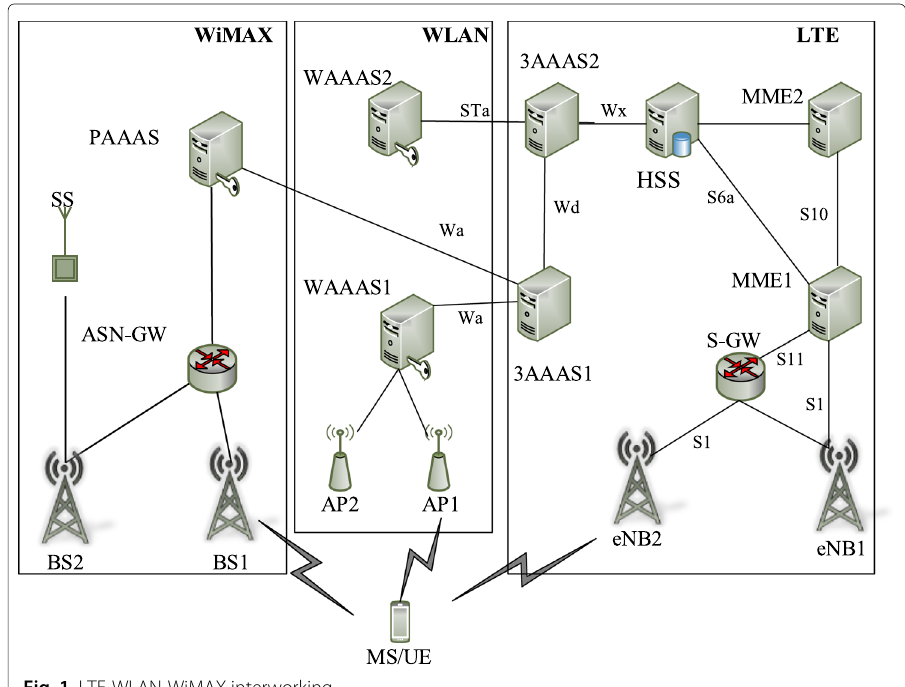
Fig. 1 LTE-WLAN-WiMAX